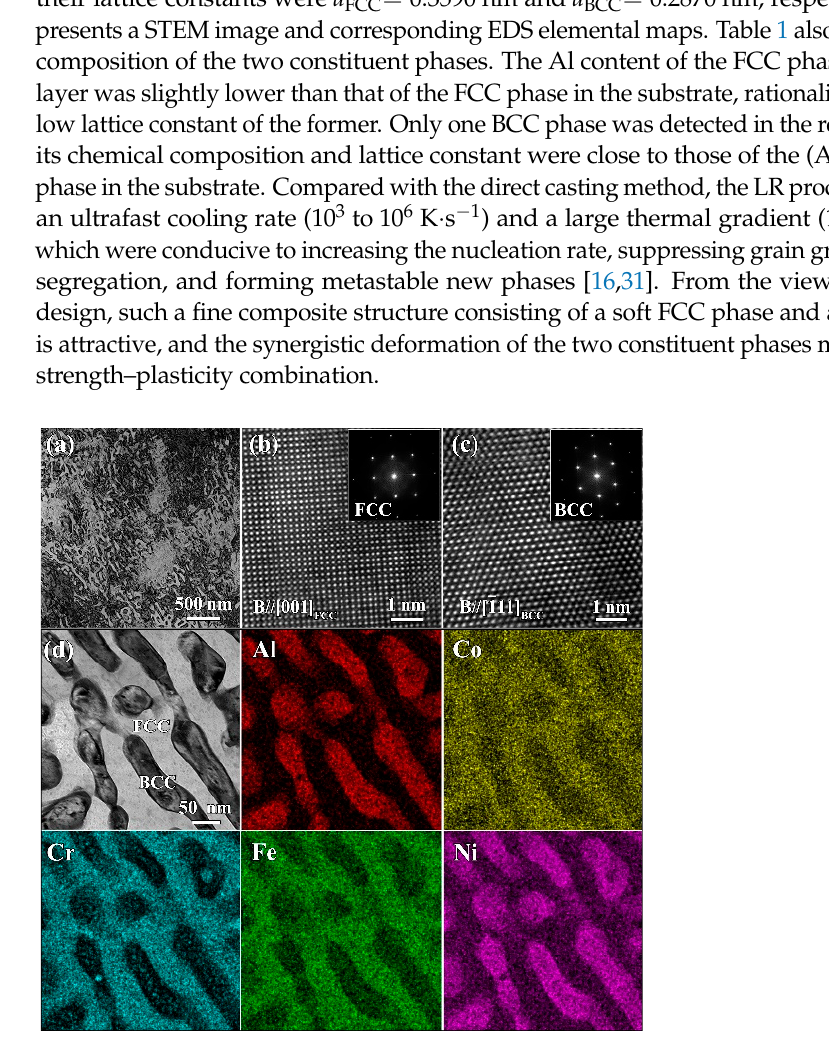
Figure 4. TEM analysis for the remelted layer. ( a ) BF image; ( b , c ) HRTEM images and FFT patterns (insets) for the two constituent phases; and ( d ) STEM image and corresponding EDS elemental maps.